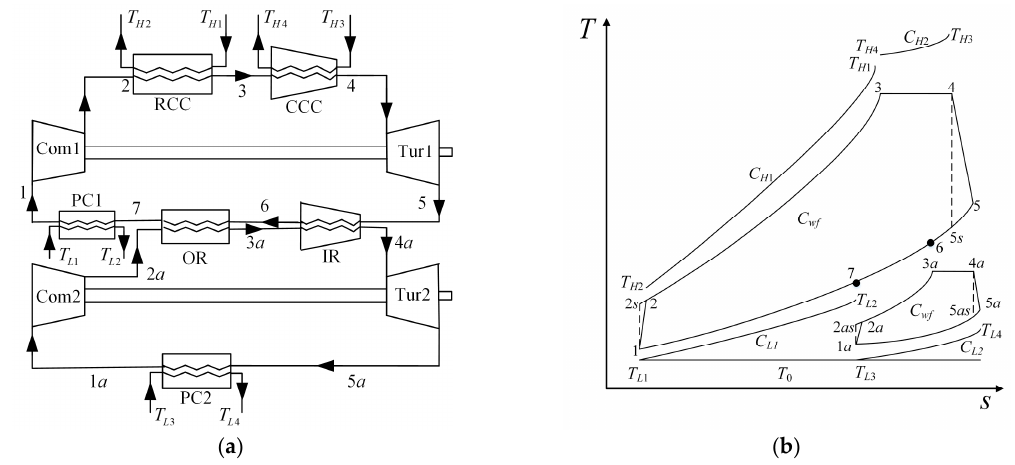
Figure 1. ( a ) Schematic diagram of the cycle [8]; ( b ) T-s diagram of the cycle.